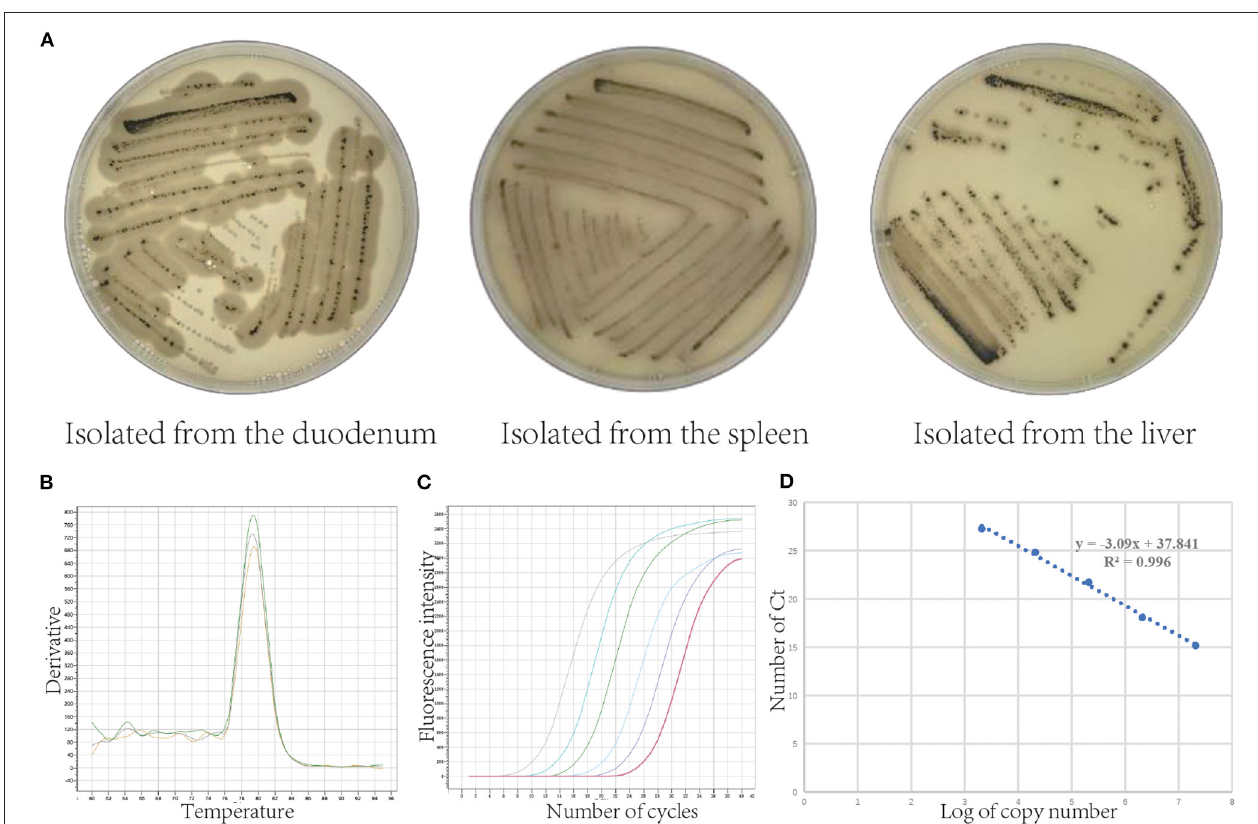
FIGURE 2 | Isolation of Clostridium perfringens and its absolute quantification standard curve. (A) Clostridium perfringens isolated from the duodenum, spleen, and liver ( Clostridium perfringens uses the sulfur in sodium metabisulphite in the TSC medium to produce hydrogen sulfide gas, which reacts with the ferrous ions in ferric ammonium citrate to produce a black ferrous sulfide substance). (B) Fluorescence quantitative PCR melting curve. (C) Fluorescence quantitative PCR amplification curve. (D) Standard curve of Clostridium perfringens .